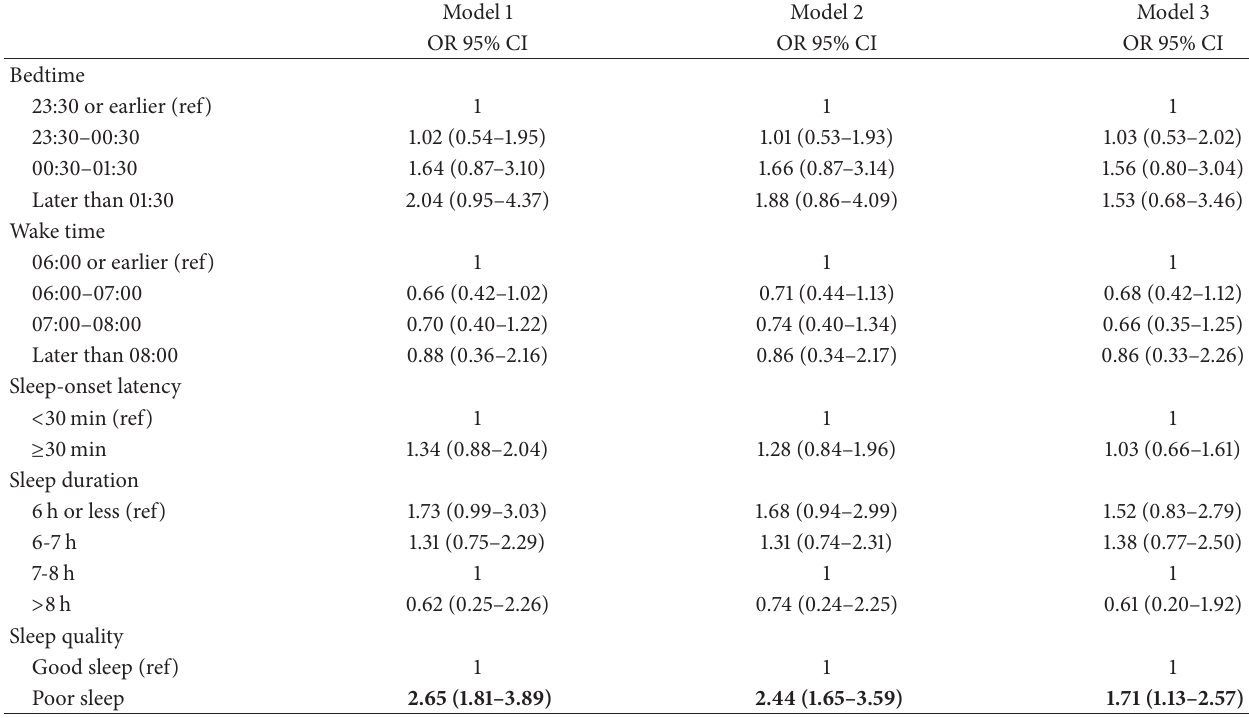
Table 4: Association between sleep behaviours and suicidal ideation according to multiple logistic regression